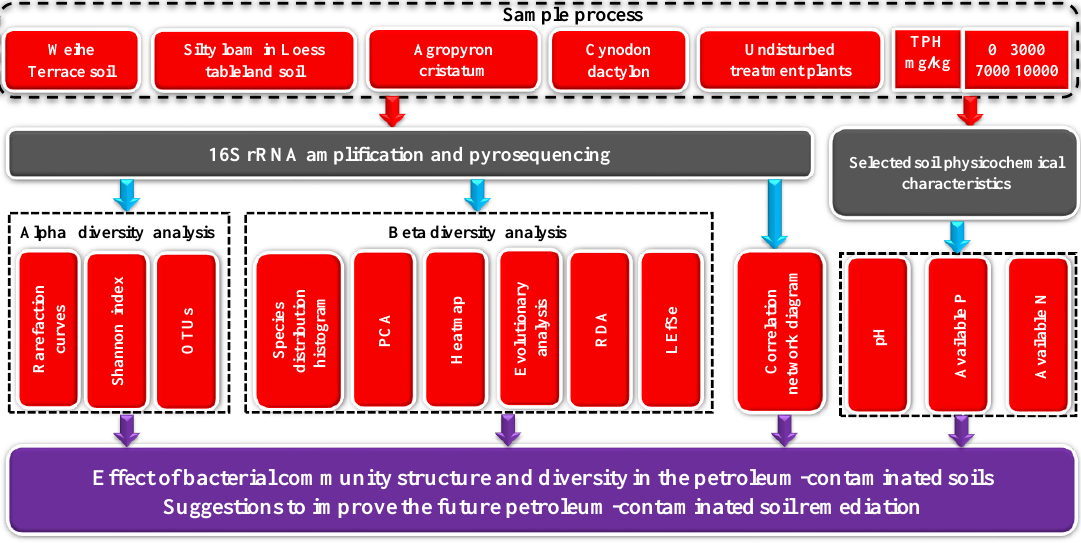
Figure 1. Framework of the analysis processes (TPH: total petroleum hydrocarbons; OTUs: operational taxonomic units; PCA: principal component analysis; RDA: redundancy analysis).